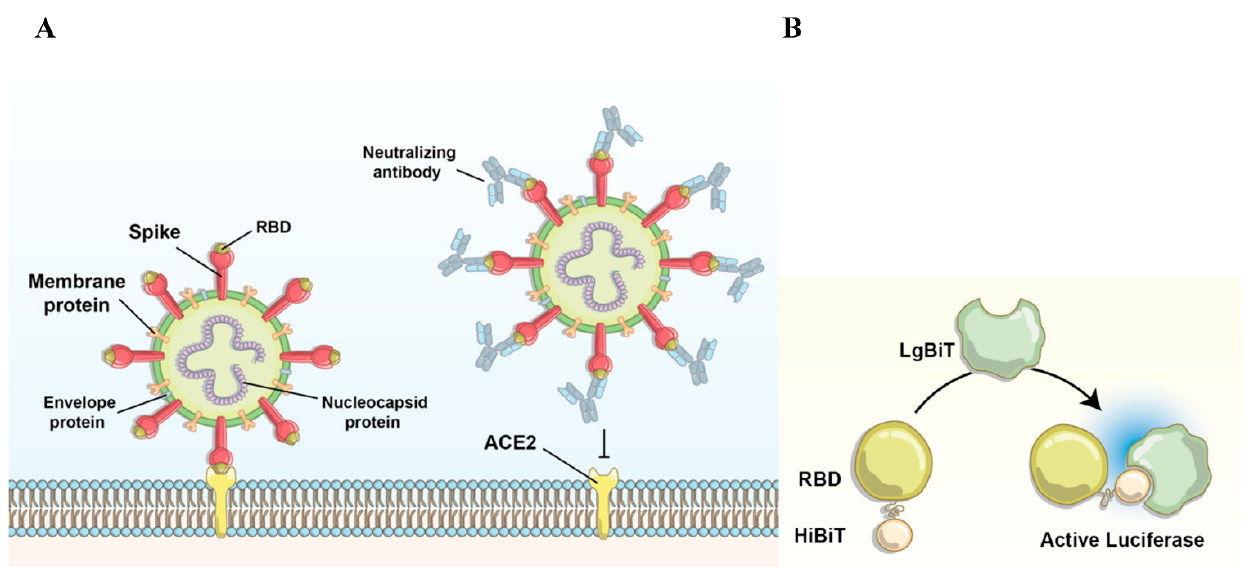
Figure 1. Illustrations of the interactions involving SARS-CoV-2 RBD. ( A ) Interactions between the RBD portion of SARS- CoV-2 and the ACE2 receptor on the host cell can be impaired via neutralizing antibodies. ( B ) Interactions between HiBiT-RBD and LgBiT lead to the generation of bioluminescence signal after substrate digestion.